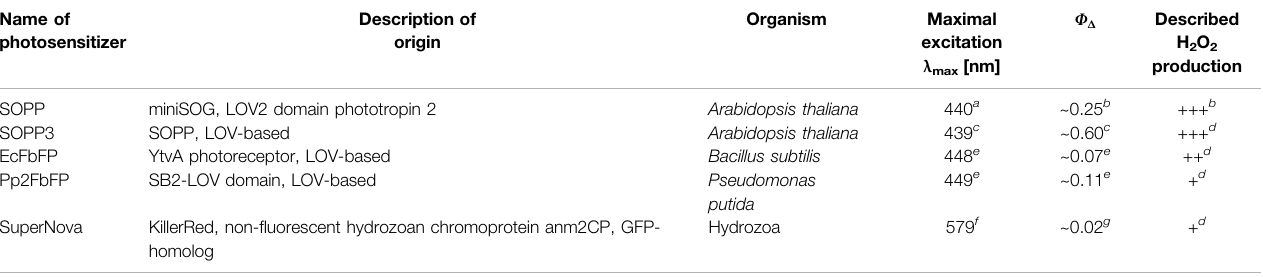
TABLE 1 | LOV- and GFP-based photosensitizers with their origin, maximal excitation wavelength ( λ max ), singlet oxygen quantum yields ( Φ Δ ) and H 2 O 2 production levels. a from Westberg et al., 2015, b from Endres et al., 2018, c from Westberg et al., 2017, d from Hilgers et al., 2019, e from Wingen et al., 2014, f from Takemoto et al.,